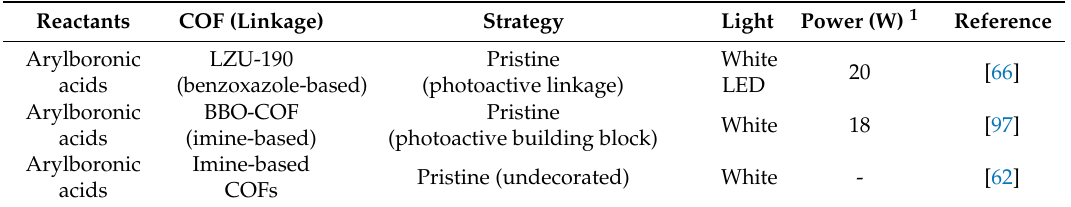
Table 8. Photooxidation reactions of arylboronic acids mediated by COFs.